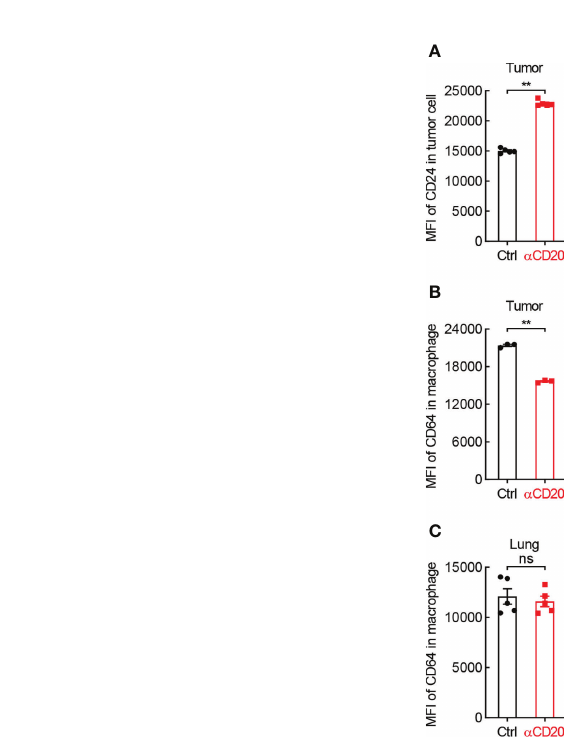
FIGURE 6 B cell shortage impedes the expression of phagocytosis-related genes in lung cancer. (A) FACS data showing elevated expression of CD24 and CD47 on tumor cells from mice with a CD20-mediated B cell depletion (n = 5). (B) FACS data showing impaired expression of PD-L1 and CD64 on tumor-in fi ltrating alveolar macrophages from mice with a CD20-mediated B cell depletion (n = 3). (C) FACS data showing reduced expression of PD-L1 but not CD64 on alveolar macrophages in lung tissues from mice with a CD20-mediated B cell depletion (n = 5). Student ’ s t test (two tailed, unpaired) was performed. Data represented means ± SEM. * p < 0.05; ** p < 0.01; ns, not statistically signi fi